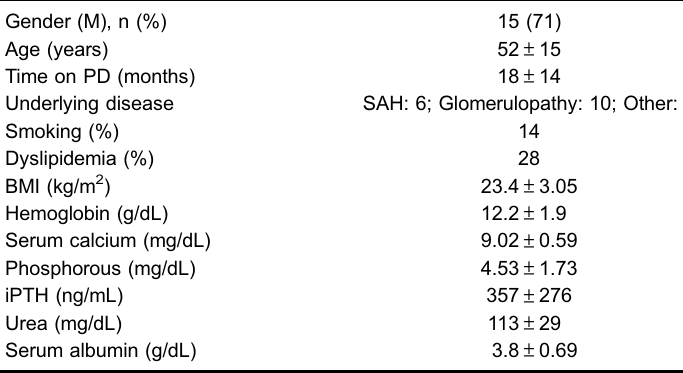
Table 1. Clinical and demographic characteristics of 21 peritoneal dialysis (PD) patients.